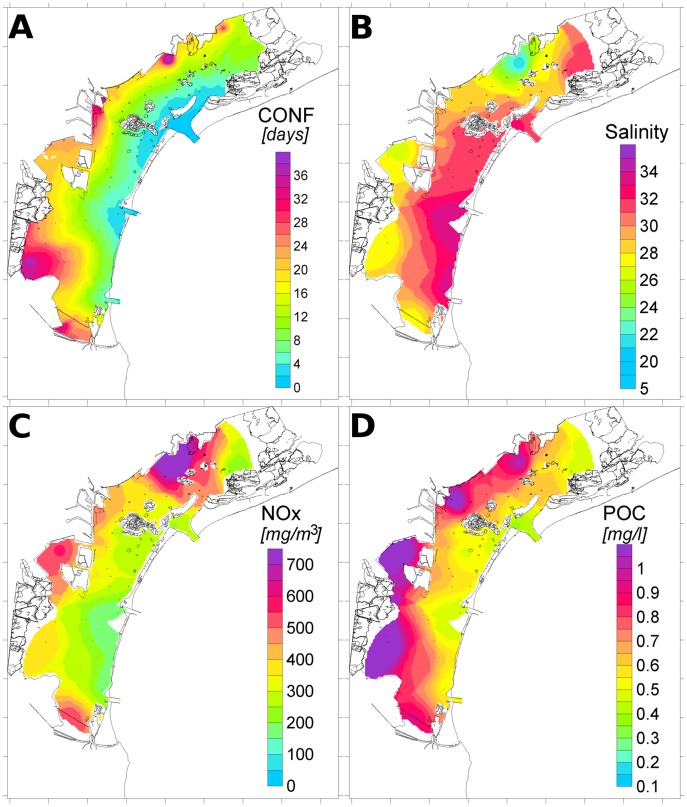
Spatial interpolation over the Venetian Lagoon of: confinement (A), salinity (B); nitrates (C); particulate organic carbon (D).